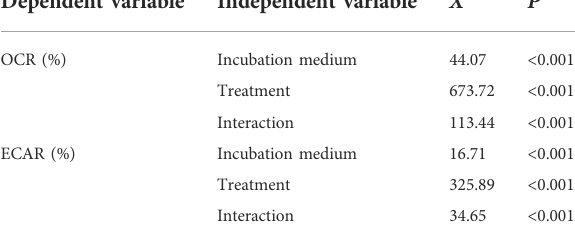
TABLE1Effectofincubationconditionsandmetabolicmodulatorson mouse sperm OCR and ECAR. Independent variables were tested as percentages relative to the basal state. Χ 2 and p values were estimated using LMMs and likelihood ratio tests. Incubation medium (non-capacitating or capacitating) and treatment (basal, 5 µM oligomycin, 1 µM FCCP, 50 mM 2DOG, and 1 µM antimycin +1 µM rotenone) were used as fi xed factors and experiment as random factor. Signi fi cant differences ( p < 0.05) are shown in boldface.